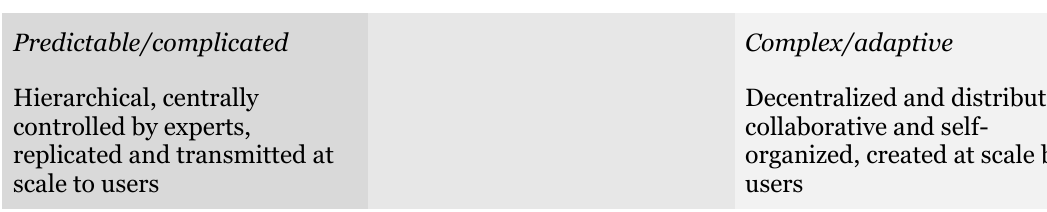
A Conceptual Model of Theories and Applications of MOOCs Learning Theories Prescriptive